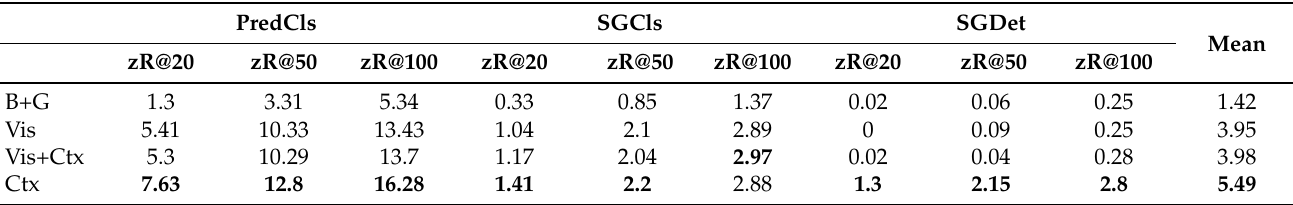
Table 8. Visual dependency reduction in terms of